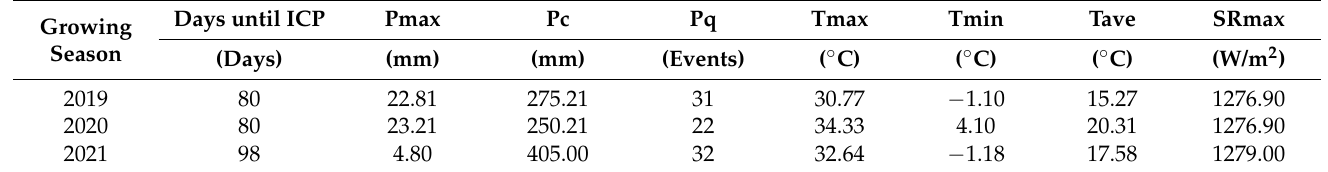
Table 3. Growing season meteorological standards from plantation to